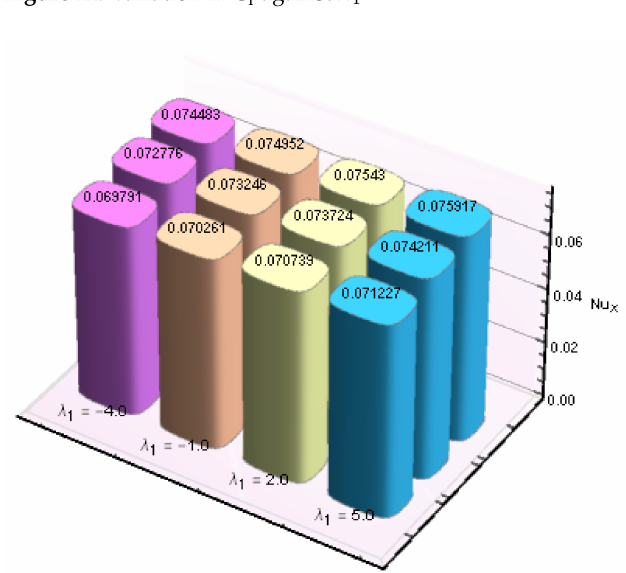
Figure 12. Variation in C f against λ 1